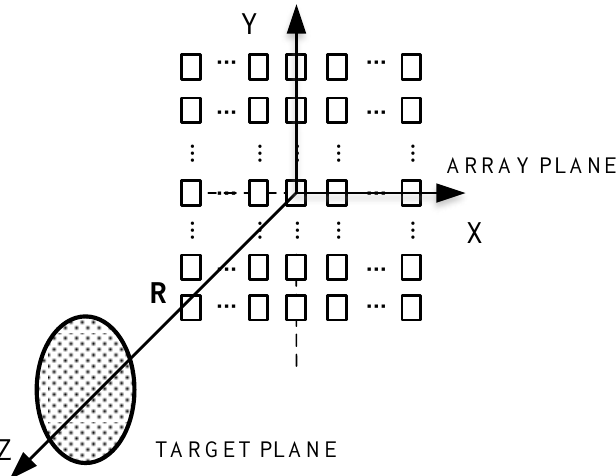
Figure 7. Schematic diagram of the target and the two-dimensional